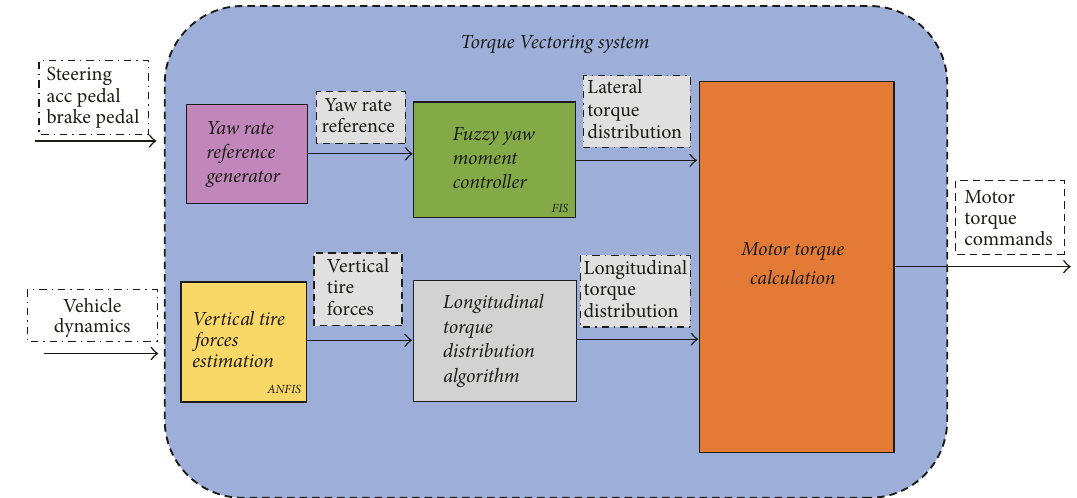
Figure 1: Proposed intelligent torque vectoring system.